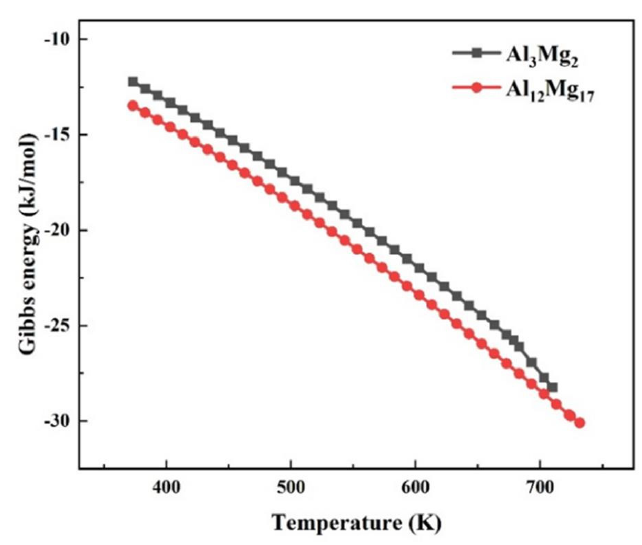
Figure 10. The Gibbs energy curve of the IMCs.